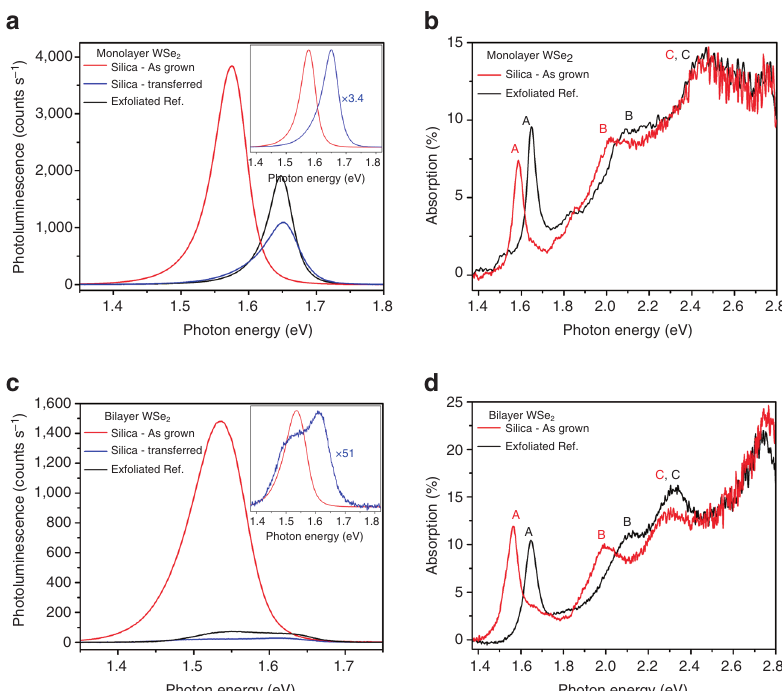
Fig. 4 Photoluminescence of strain-engineered monolayer and bilayer WSe 2 . a Photoluminescence spectra of as-grown and transferred monolayer WSe 2 as well as exfoliated reference. Inset shows normalized spectra. b Absorption spectra of as-grown and exfoliated monolayer WSe 2 . c Photoluminescence spectra of as-grown and transferred bilayer WSe 2 as well as exfoliated reference; inset shows normalized PL spectra of as-grown and transferred